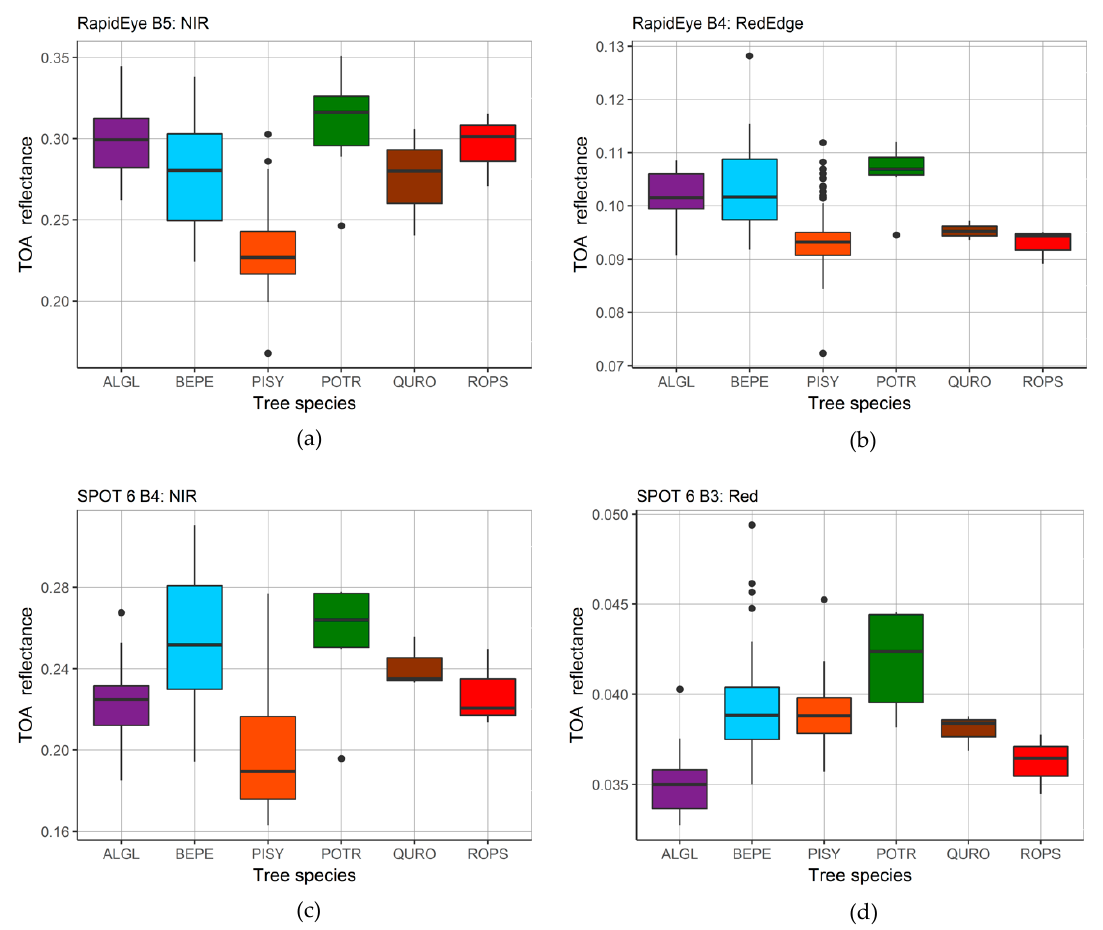
Figure 1. Box-whisker plots of top-of-atmosphere (TOA) reflectance for six tree species: ( a ) RapidEye near infrared band reflectance; ( b ) RapidEye red edge band reflectance; ( c ) SPOT 6 near infrared band reflectance; ( d ) SPOT 6 Red band reflectance.